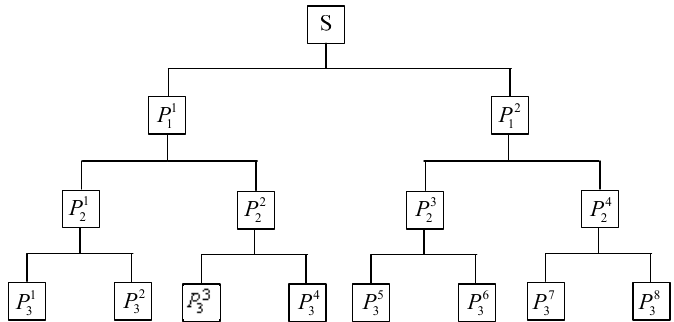
Figure 5. Wavelet packet decomposition tree for decomposition of the original signal.